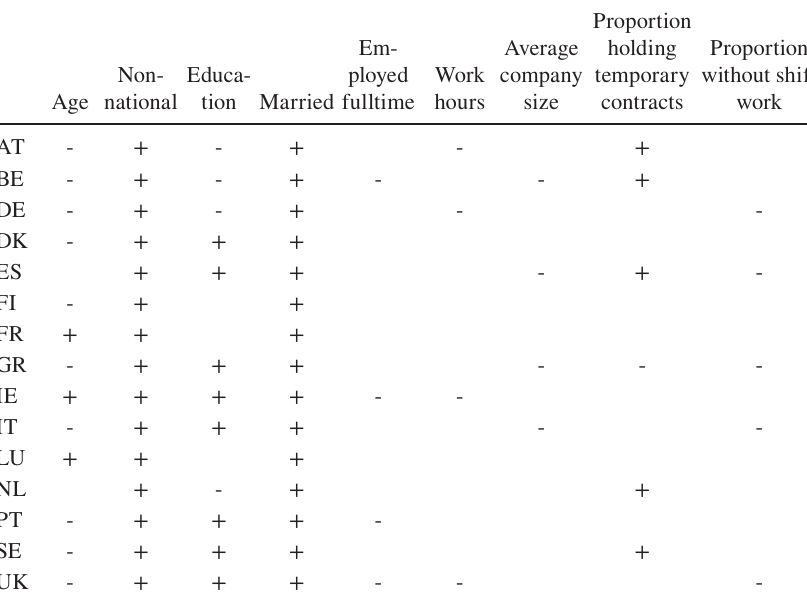
Table A1: Ethnic occupational segregation in EU-15 countries based on multi- level simulation approach. The table shows significantly (p < .05) po- sitive or negative associations of the predictors with the proportion